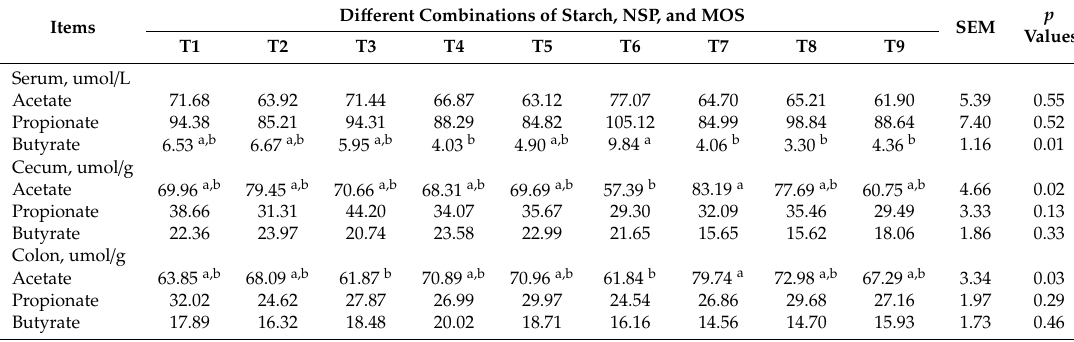
Table 10. E ff ects of di ff erent combinations of starch, NSP, and MOS on the short-chain fatty acids concentrations of weaned